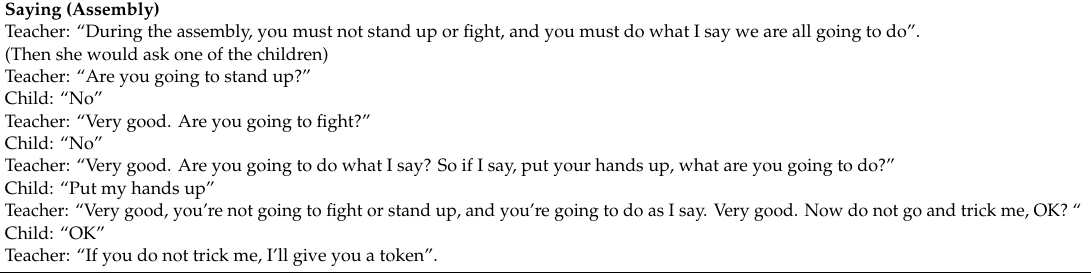
Table 1. Training in the Say-Do-Say correspondence of several behaviors carried out by the